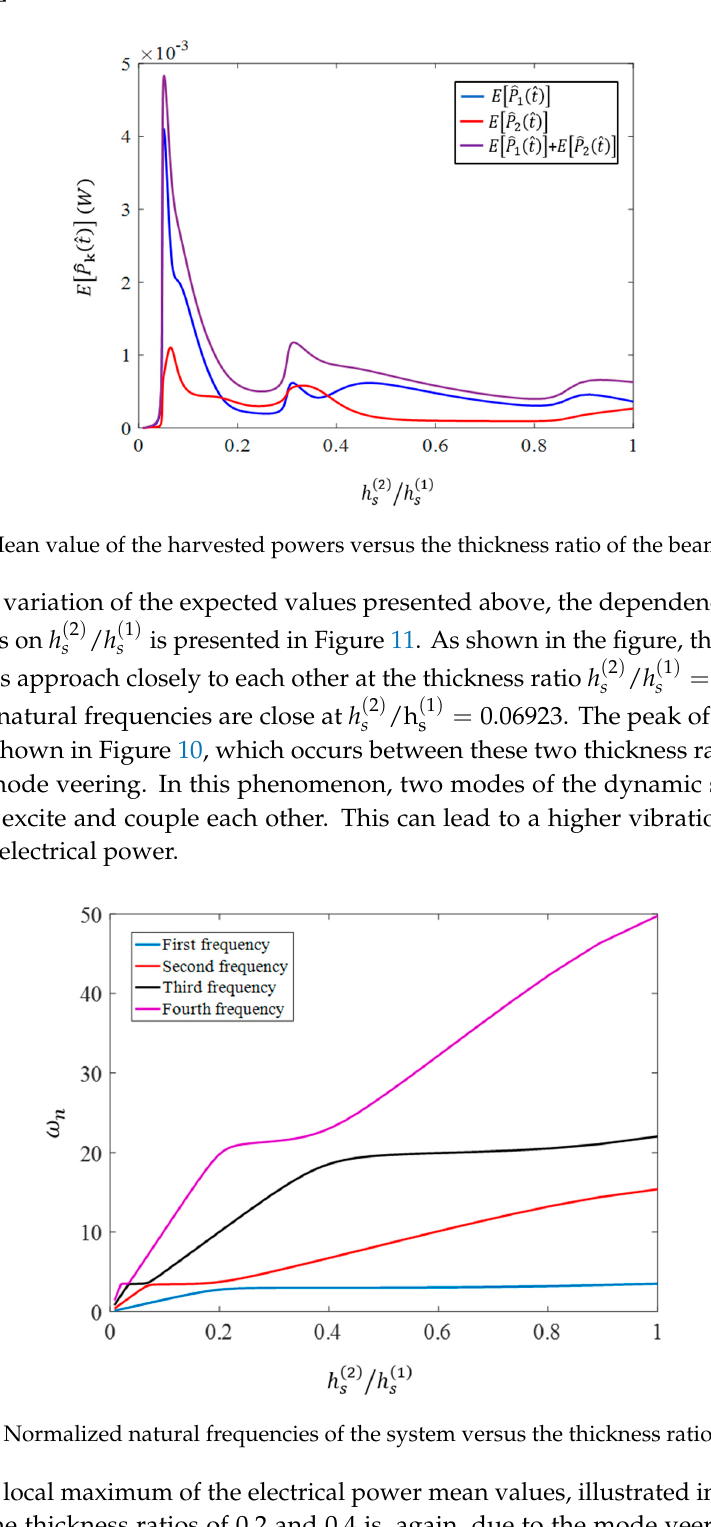
Figure 11. Normalized natural frequencies of the system versus the thickness ratio h